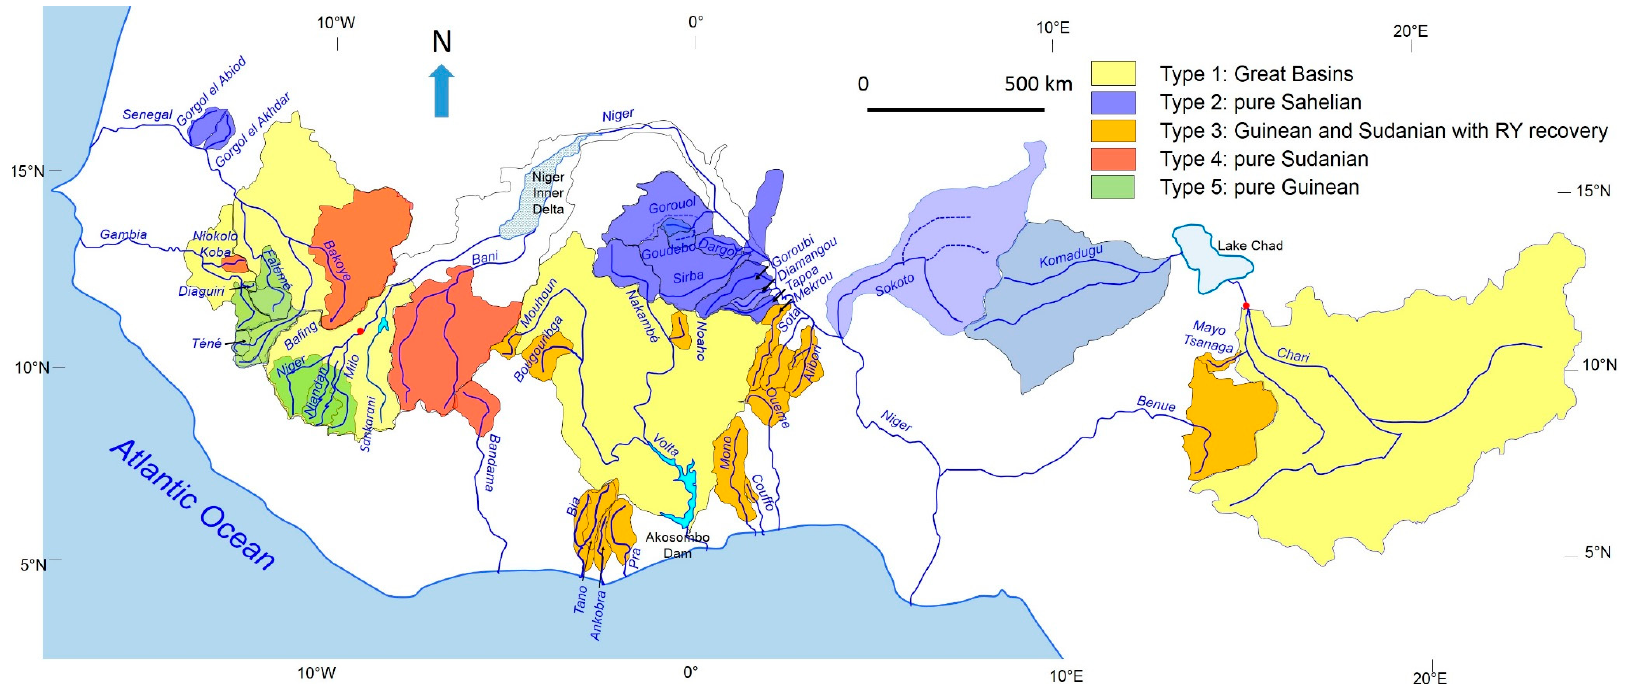
Figure 5. Classification of rivers basins according to the five described types (Volta River was added, despite the biases introduced by Akosombo dam, in Type 1, as the literature well describes its behavior); Sokoto is type 2, since an increase in RC is observed, but data are very sparse [2,3,15,49,61,63,64,68,72]; Komadugu has the same behavior as the Sahelian Basin (personal communication with Pierre Genthon, IRD).